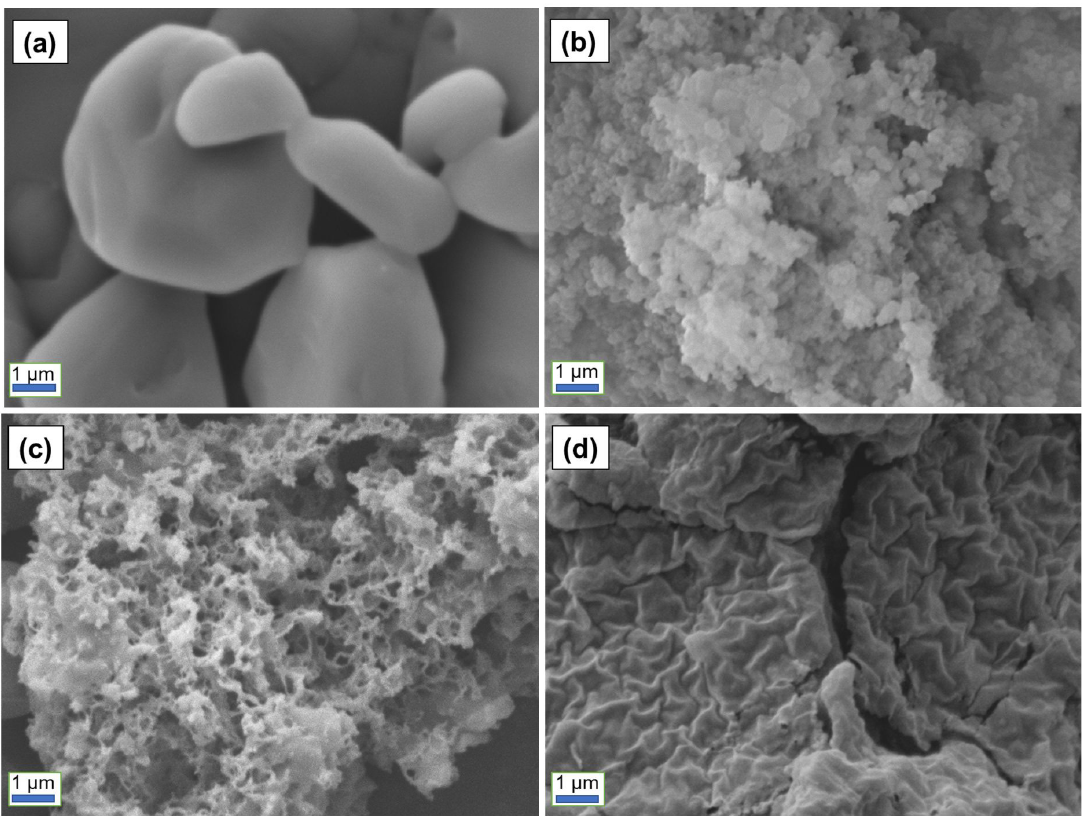
Figure 4. SEM images of (a) melamine, (b) purified silica obtained from sodium silicate neutralized with acetic acid, (c) PMF, and (d) dry PMF-Si